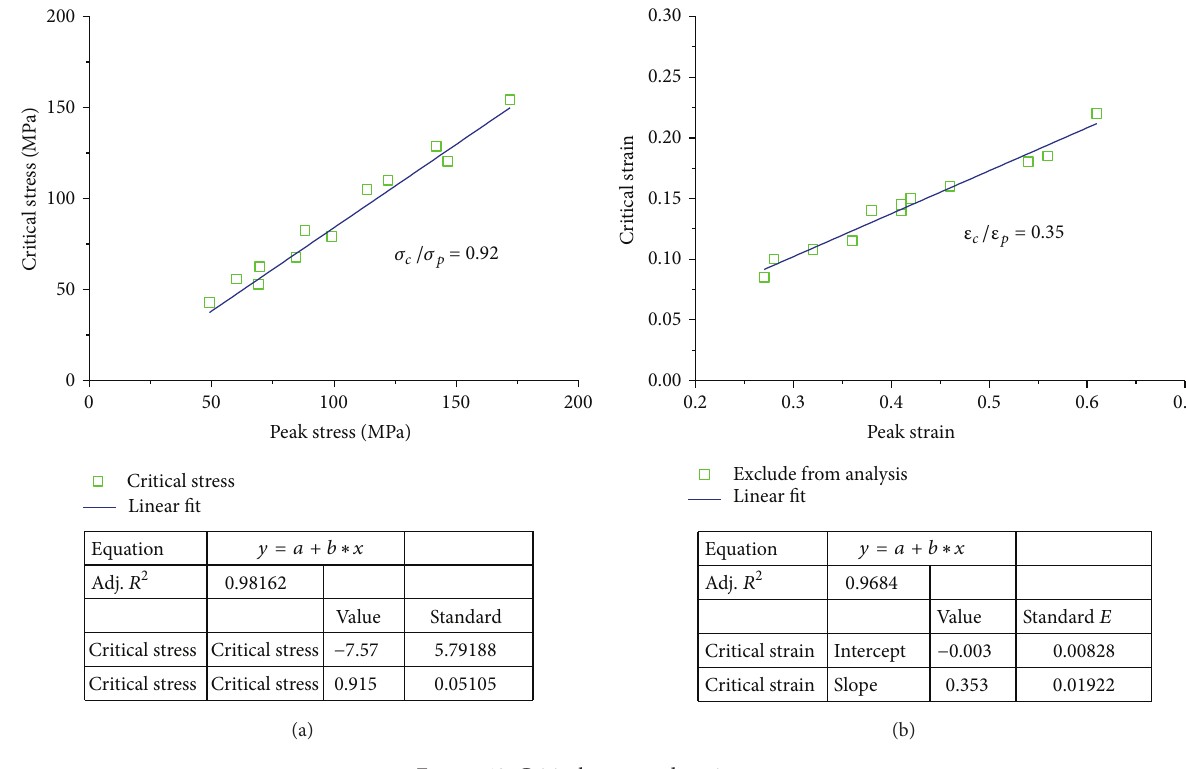
Figure 10: Critical stress and strain curves.